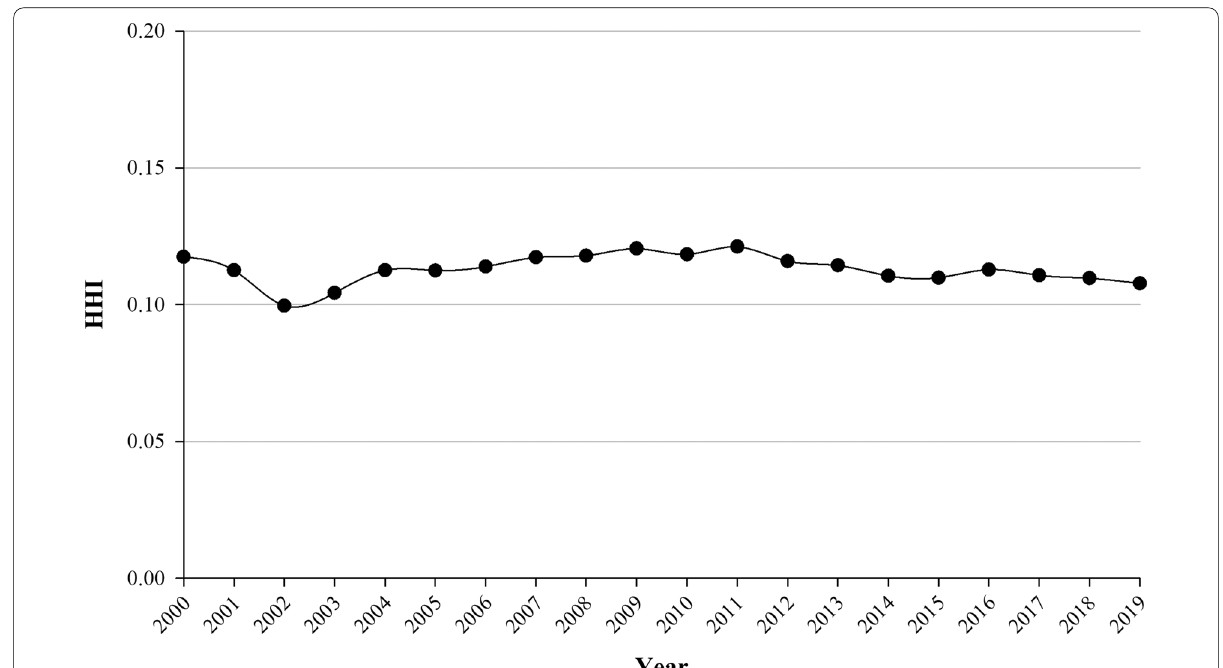
Fig. 4 Evolution of HHI from 2000 to 2019 for the set of Baltic ports